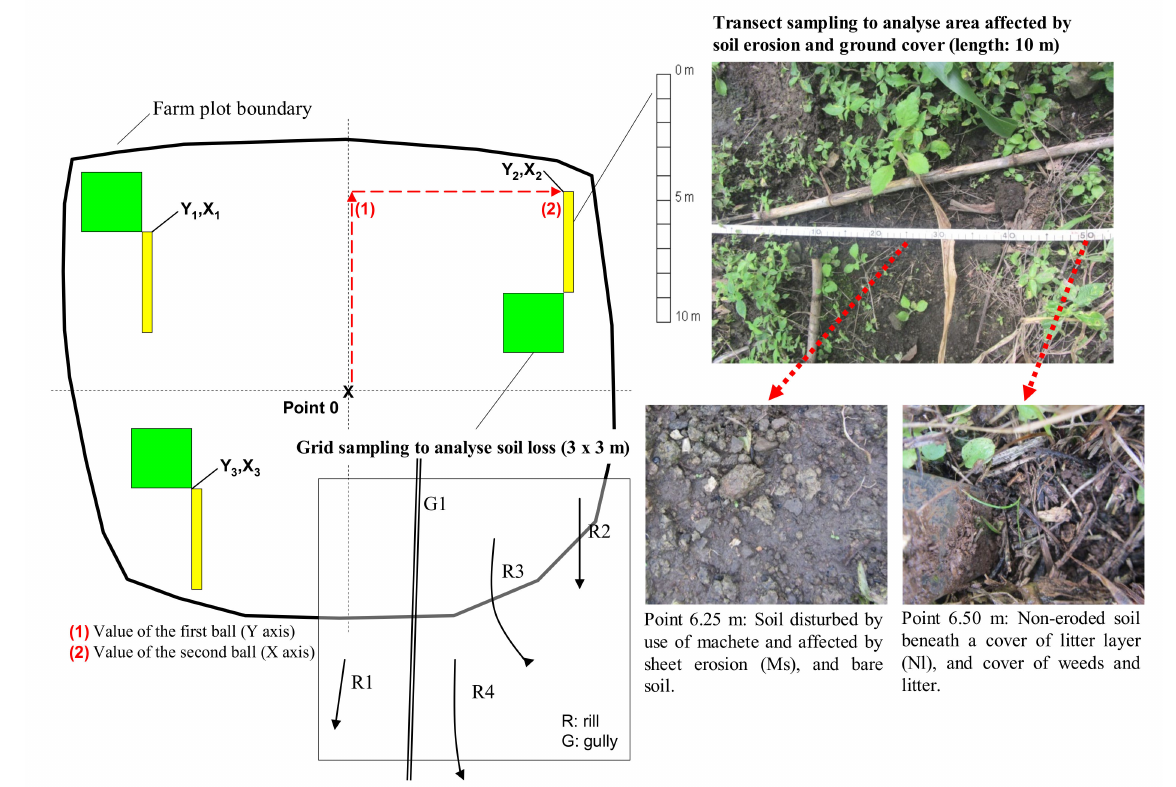
Figure 3. Sampling procedure to establish soil erosion and ground cover (adapted from Blanco [25]). The transects and grid squares originated from point 0 in the sample plot. The distances of the x–y axes were randomly determined by the blind extraction of numbered balls. Each transect was 10 m long and samples were taken at 25 cm intervals (in total, there were 40 observation points of the erosion indicators and of ground cover per transect, i.e., 120 observations were made per plot, and 1920 in the total of the 16 plots studied). The grid squares measured 3 × 3 m and were used to measure the length, width and depth of all the rills and gullies